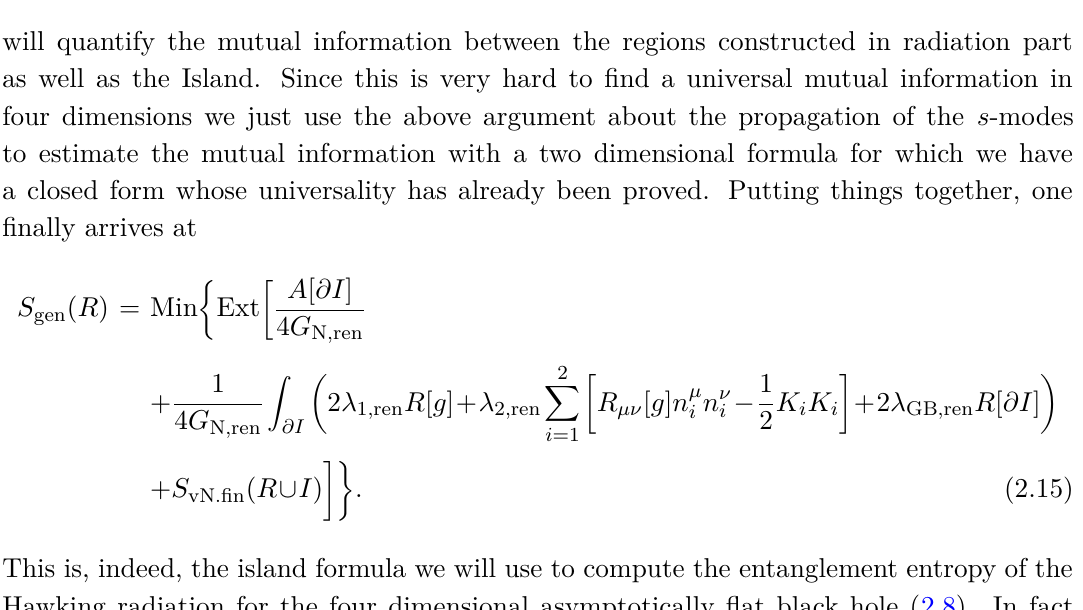
Figure 1 . Entanglement regions in the radiation part with the assumption that there is an island inside the black hole. The fictitious boundaries shown by violet lines at r = r 0 are the regions over which the gravity is negligible that are the radiation regions. At early times assuming that there is an island results in an imaginary solution for the location of island indicating that there is no island at early times and thus the whole contributions come from the matter von Neumann